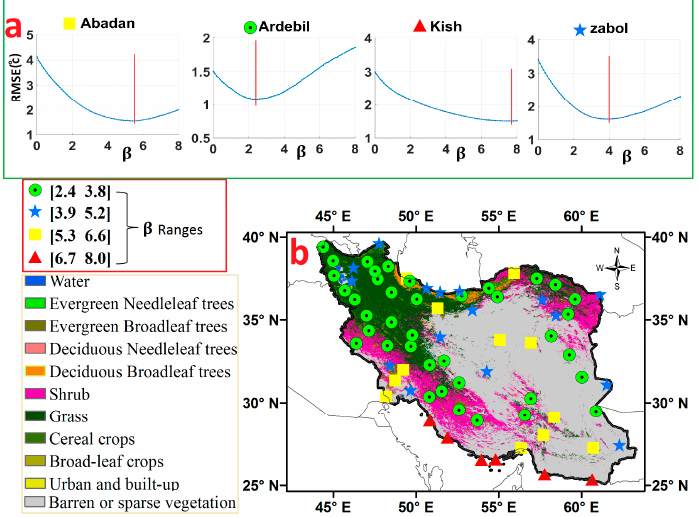
Figure 4. Estimated β range over study area for each weather station. ( a ) Empirical estimation of the β parameters for Abadan, Zabol, Ardebil, and Kish station, and ( b ) estimated β for all stations for different land covers in the study area.